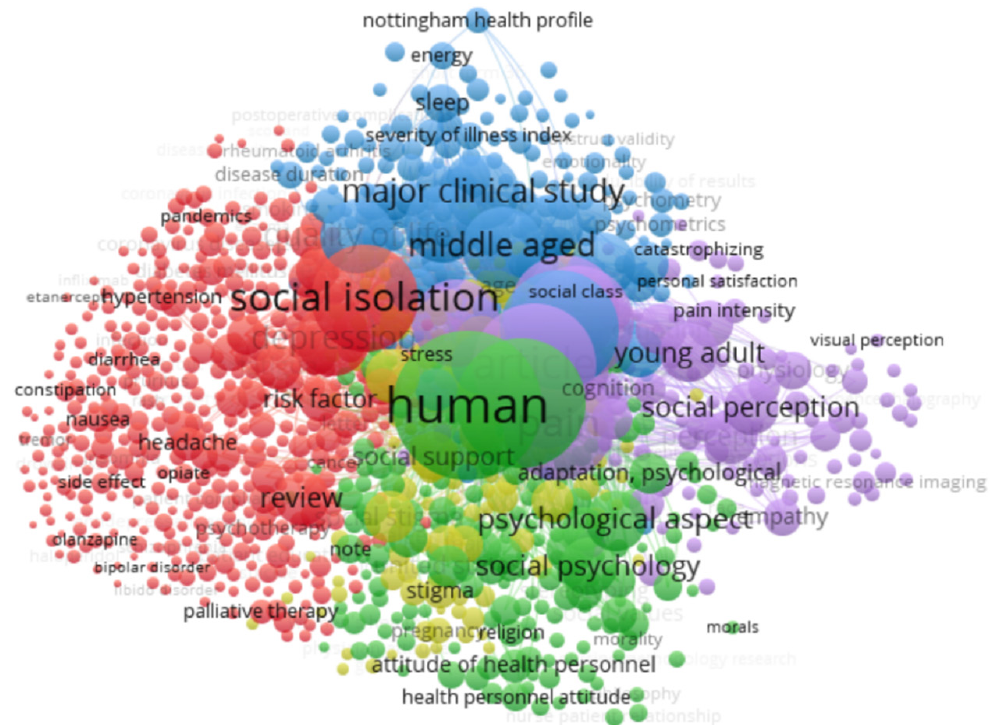
Figure 2. Chart showing the main nodes (keywords) applying the final filtered search strategy on Scopus (Using the VOSviewer software (Centre for Science and Technology Studies, Leiden University, The Netherlands. Version 1.6.16.)).